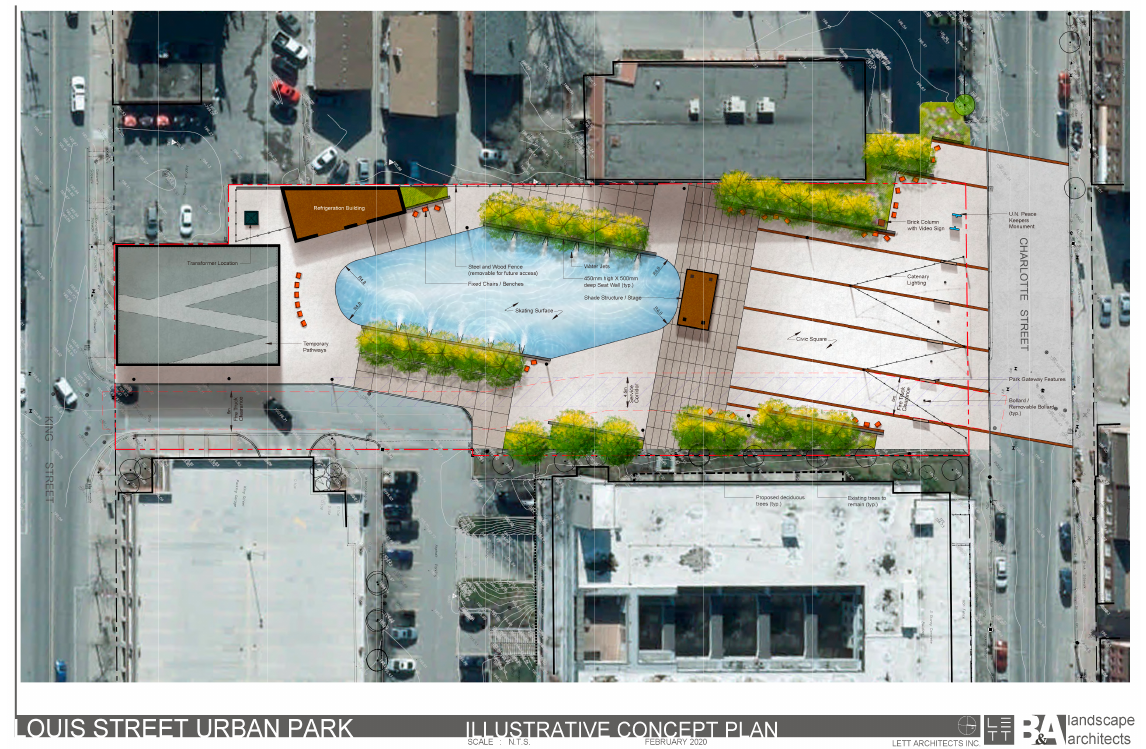
Figure 2. Proposed urban park conceptual plan (Source: LETT ARCHITECTS Inc.).